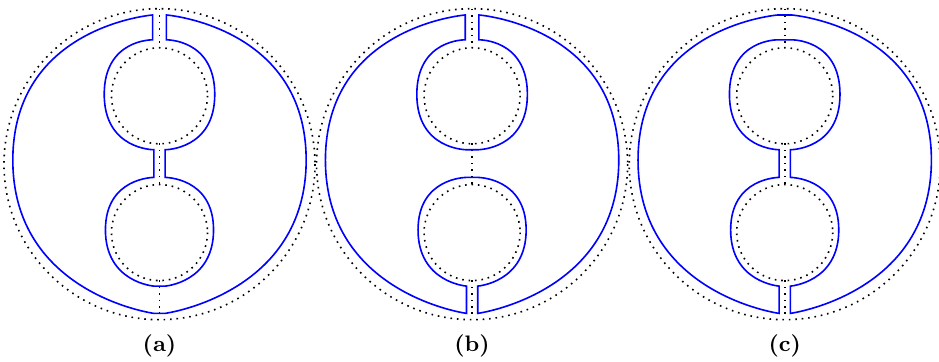
Figure 31. By deleting pairs of consecutive edges that are inverses of each other in the paths in (cid:12)gure 30, we arrive at the loops shown